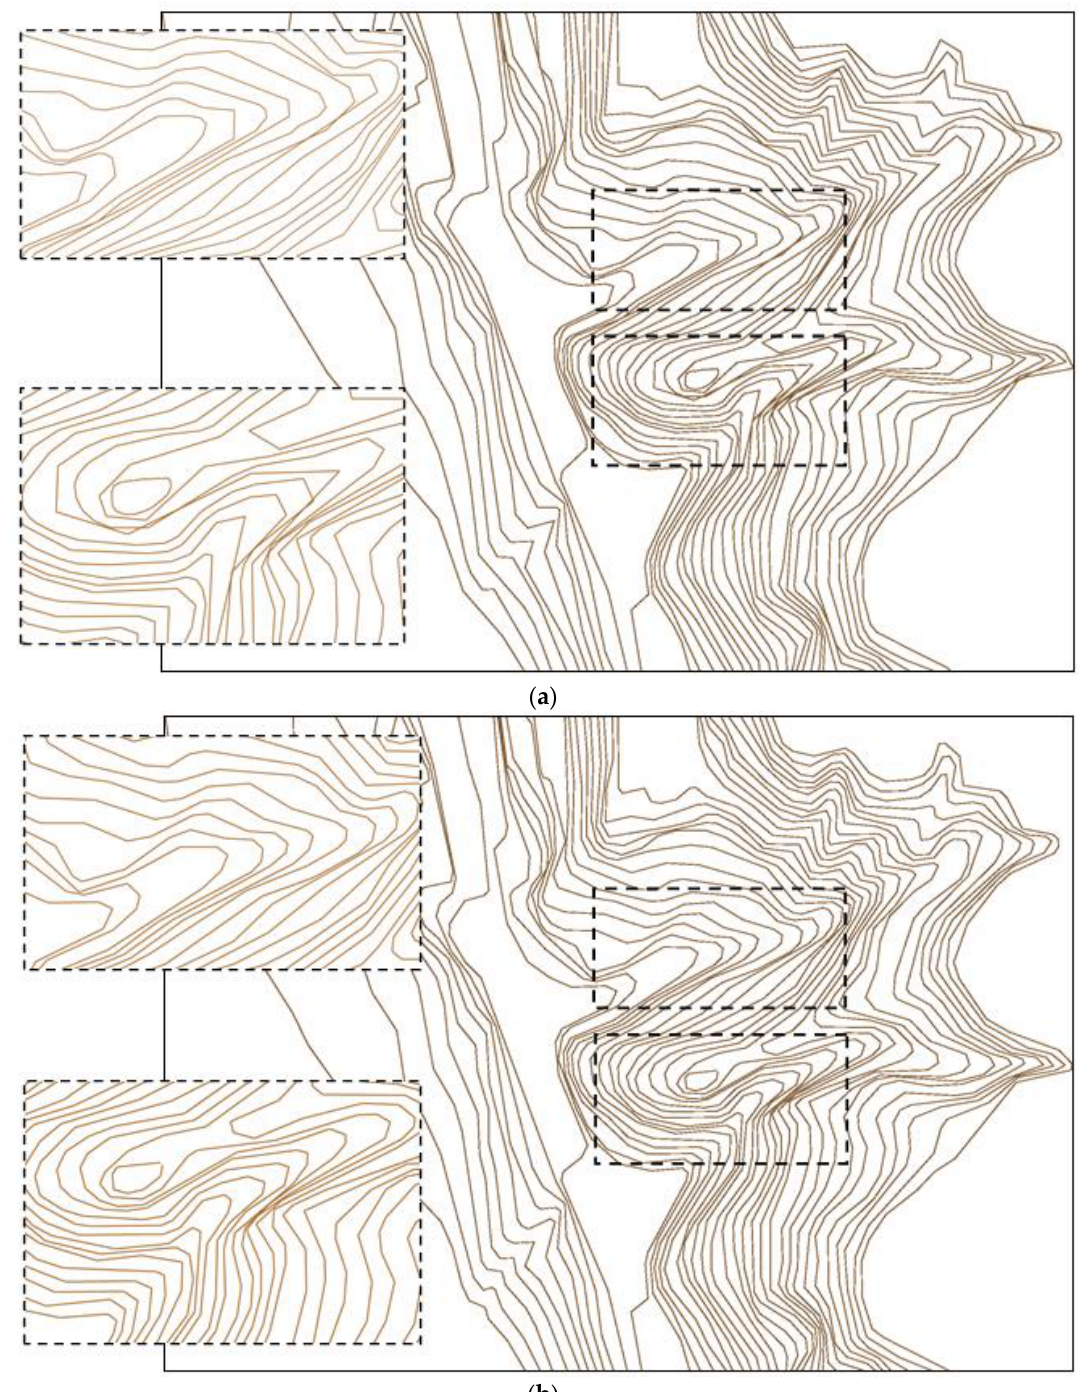
Figure 21. Comparison of the simplified results with similar compression rates: ( a ) the simplified results with the orthographic division and DP-algorithm (composed of 1274 shape points); and ( b ) Simplified result with ODC method and DP-algorithm (composed of 1267 shape points).